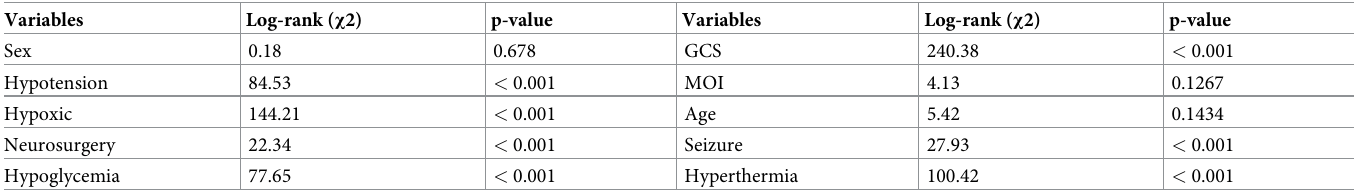
Table 3. Comparisons of death among different levels of predictor variables using the log-rank test for head injury patients to HUCSH from July 2017–July 2019, Hawassa, southern Ethiopia. Variables Log-rank ( χ 2)